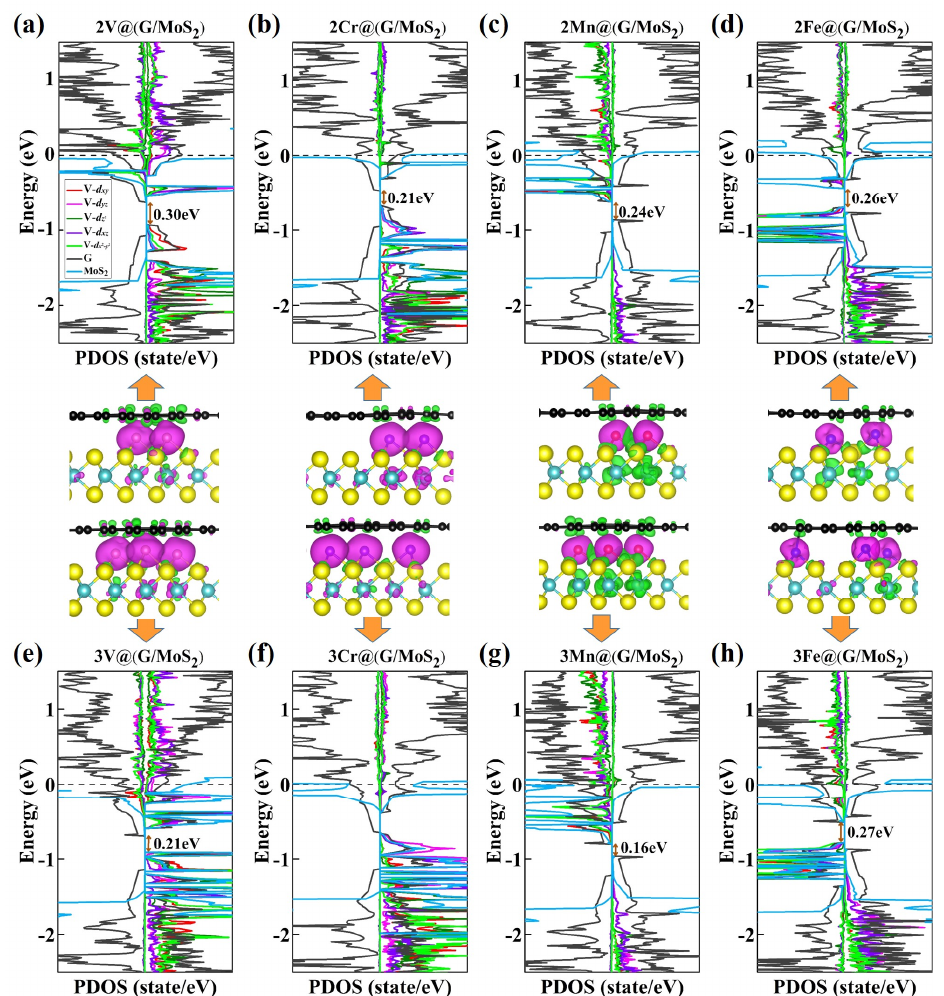
Figure 5. Partial density of states (PDOS) and spin density plots for ( a – d ) 2TM@(G/MoS 2 ) and ( e – h ) 3TM@(G/MoS 2 ) (TM = Ti, V, Cr, Mn).